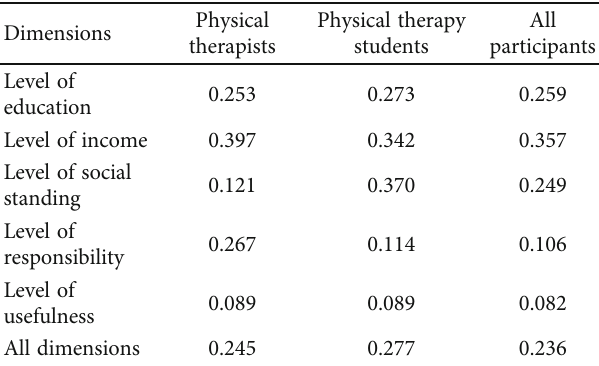
Table 2: Degree of consensus (Kendall ’ s coe ffi cient of concordance — W